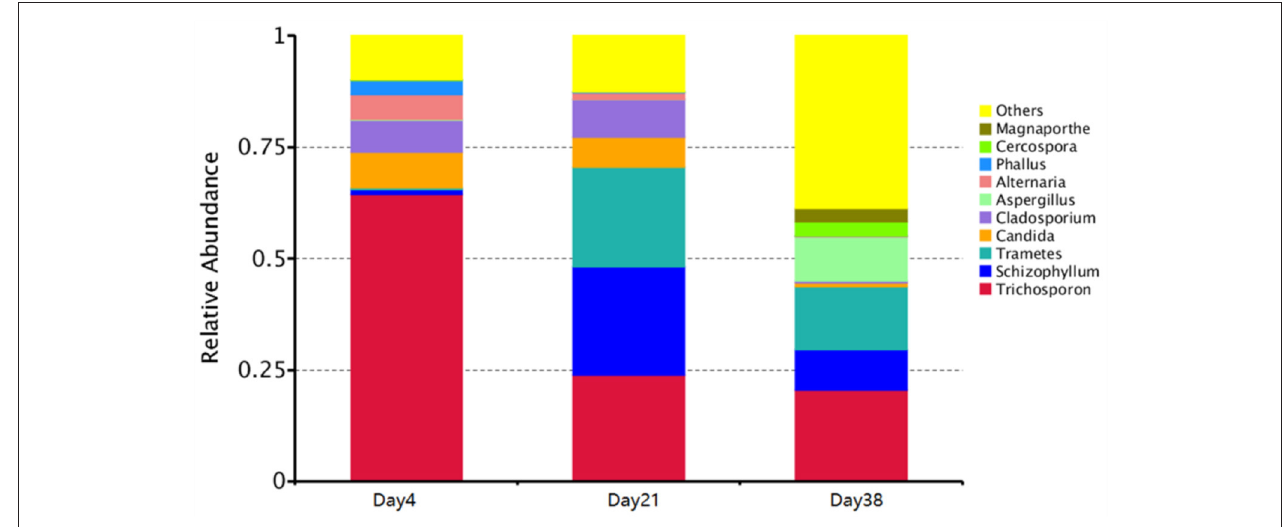
FIGURE 5 | Graph of the relative species abundance of each sample at the genus level. X-axis indicates each sample and Y-axis indicates relative